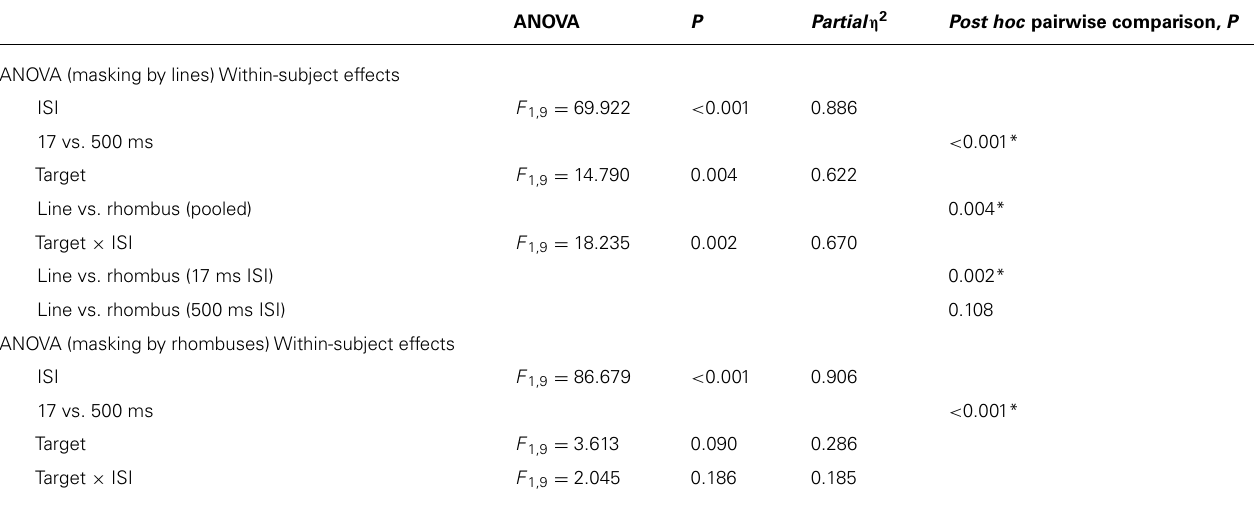
Table 3 | Repeated MeasuresANOVA and post hoc pairwise comparisons for Experiment 3 ( n = 10). ANOVA P Partial η 2 Post hoc pairwise comparison,